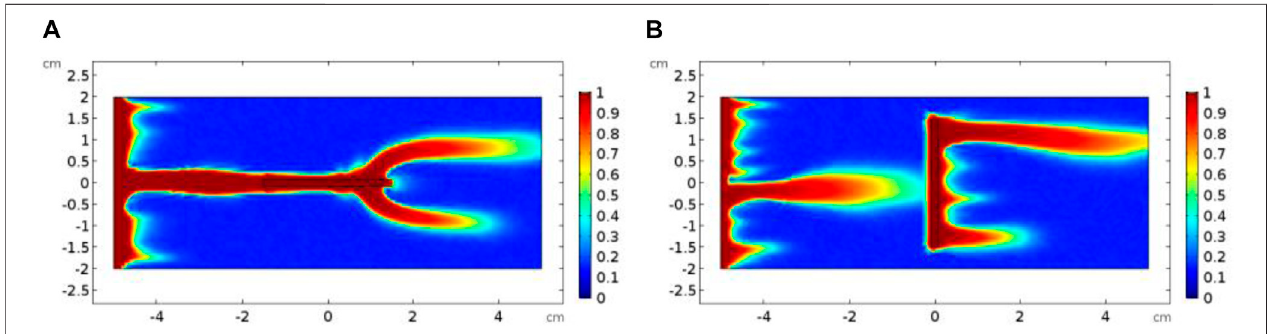
FIGURE 13 | Comparison of dissolution images of isolated fracture core samples: (A) horizontal fracture; (B) vertical fracture.